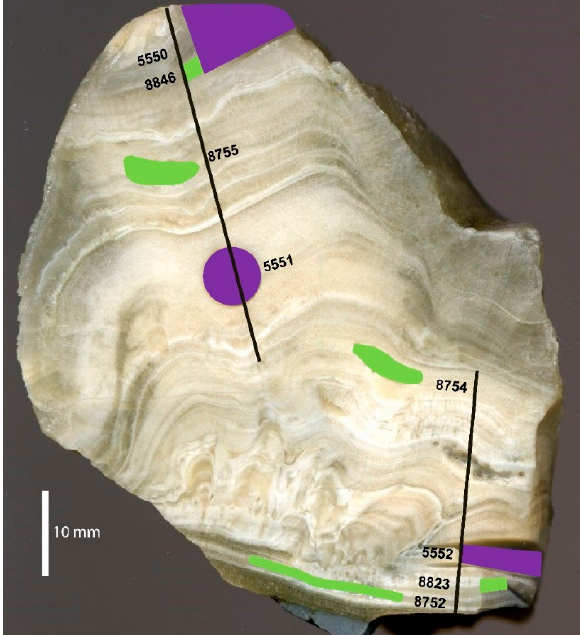
Figure 2. Cross-section of speleothem Kf-21. Positions for TIMS dates are marked with purple polygons; MC-ICPMS dates are marked with green polygons. ID-numbers correspond to ID-numbers in Table 1. Note the large samples for TIMS dating. The position of the sampling for carbon and oxygen isotope compositions is indicated by black lines.